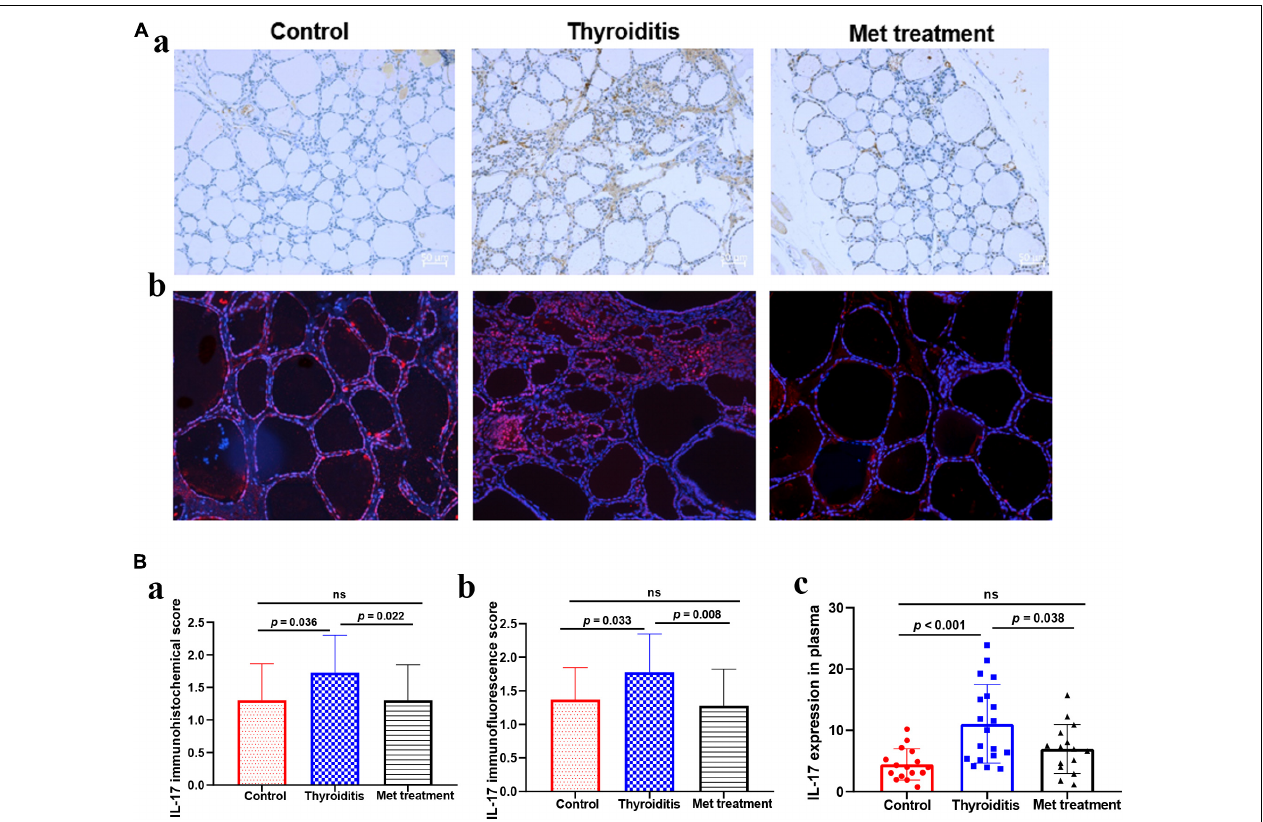
FIGURE 3 | (A) IL-17 Immunohistochemistry and immunofluorescence of thyroid tissue, (a) IL-17 immunohistochemistry, (b) IL-17 immunofluorescence. (B) The expression level of IL-17 in thyroid tissue and plasma, (a) the immunohistochemical score of IL-17 in thyroid tissue, (b) the immunofluorescence score of IL-17 in thyroid tissue, (c) the expression level of IL-17 in plasma detected by